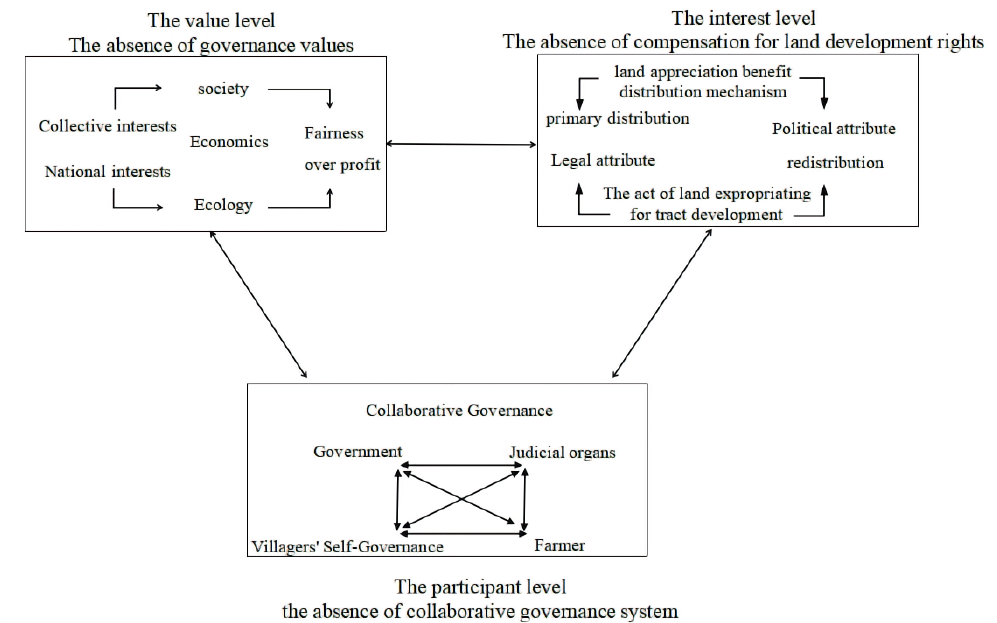
Figure 2. The logic of multiple deconstruction of the failure of land expropriation standards for tract development under the system of “Good Land